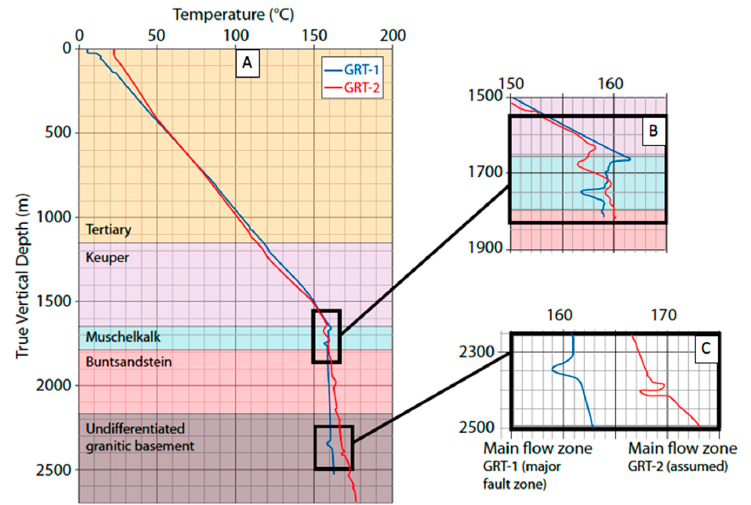
Figure 8. High ‐ resolution temperature profile ( A ) in both GRT ‐ 1 and GRT ‐ 2 wells at Rittershoffen, modified after [10]. The general thermal gradient shows a slope break at the boundary between Muschelkalk and Keuper. Local ‐ scale major temperature anomalies are highlighted in small rectangles in the Muschelkalk ( B ) and in the granite ( C ).